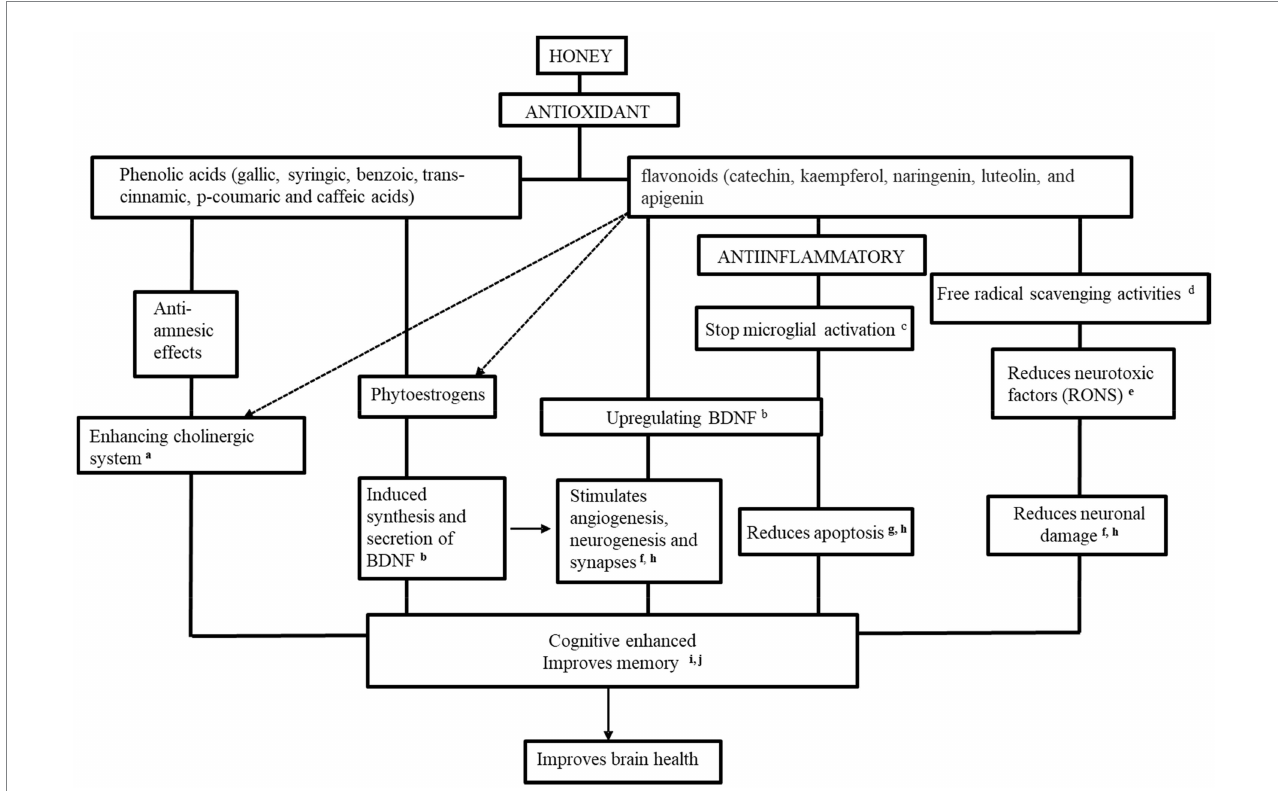
FIGURE 3 The potential therapeutic mechanisms of honey as a promising brain booster. a Al-Himyari (2009), b Al-Rahbi et al. (2014a), c Mohd Sairazi et al. (2018), d Mohd Shafie et al. (2022), e Hasim et al. (2020a), f Abd Aziz et al. (2020), g Qaid et al. (2020a), h Adeniyi et al. (2022), i Yahaya et al. (2020), and j Othman et al.